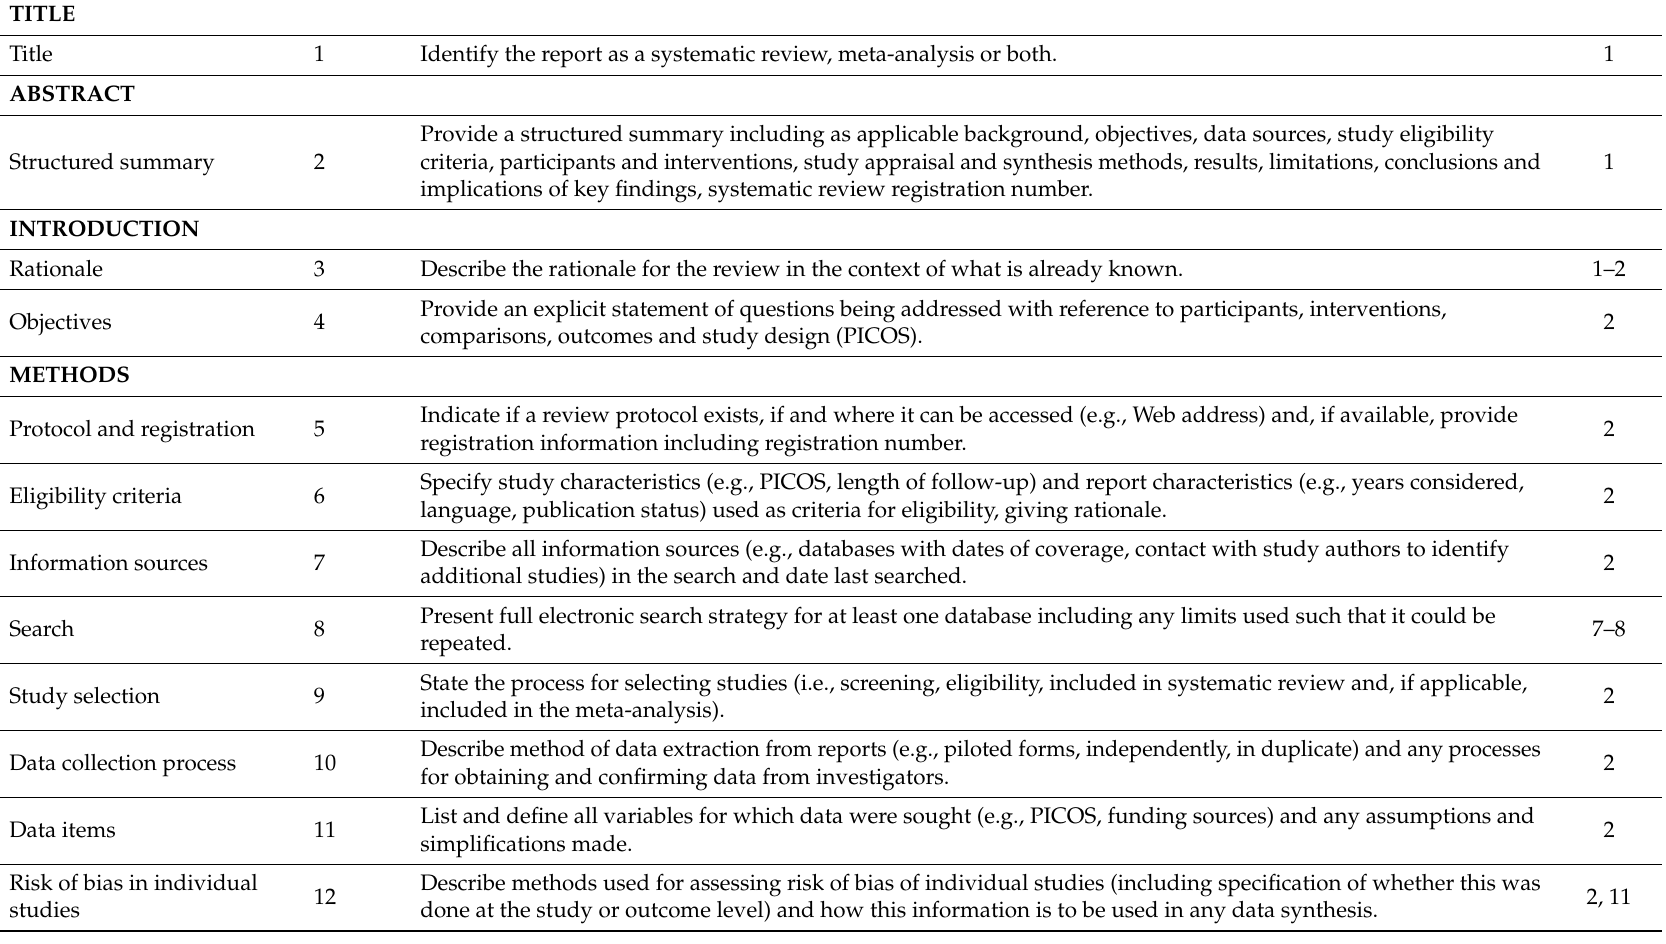
Table A2. Preferred Reporting Items for Systematic Reviews and Meta-Analyses (PRISMA) 2009